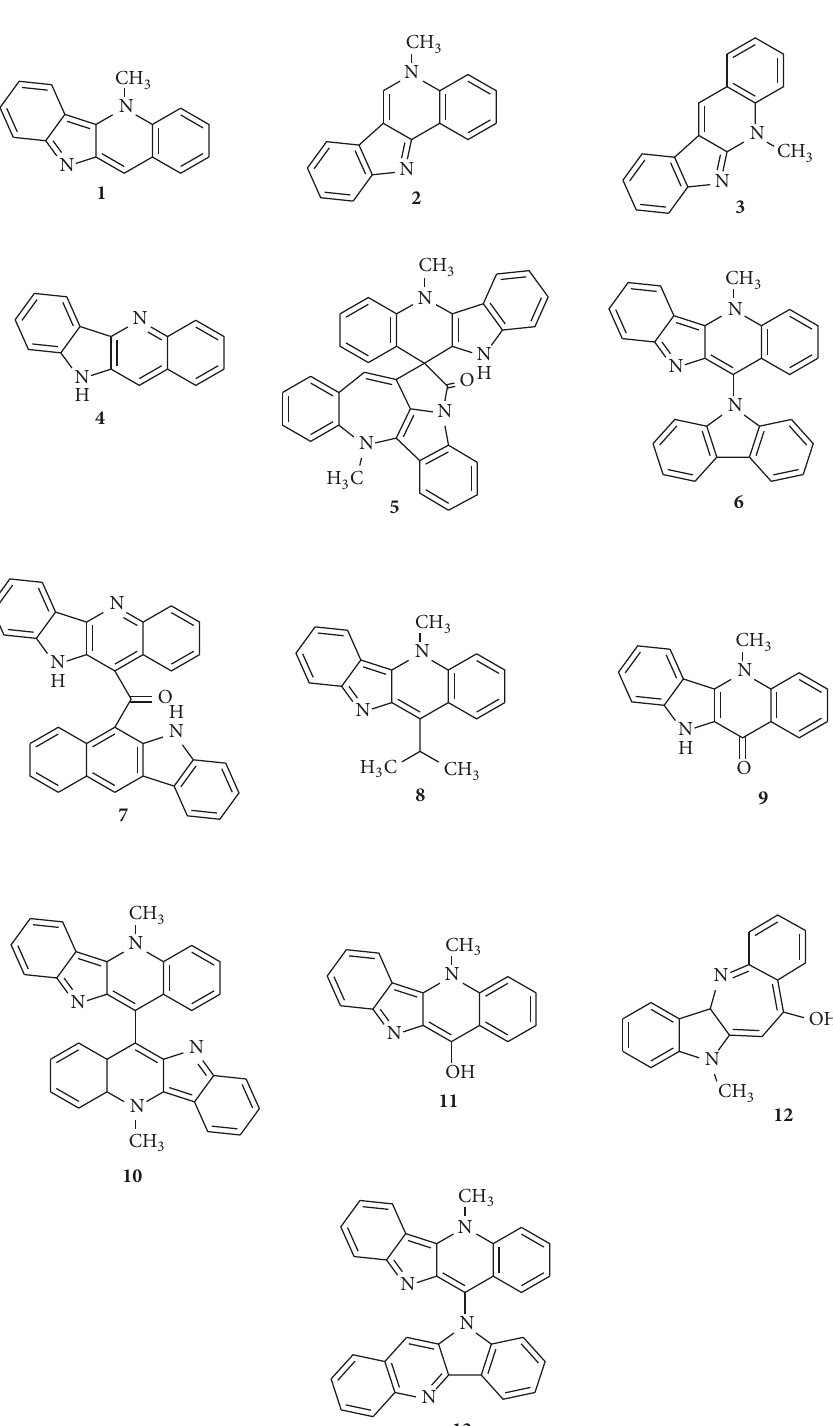
Figure 2: Structures of alkaloids isolated from the root of Cryptolepis sanguinolenta